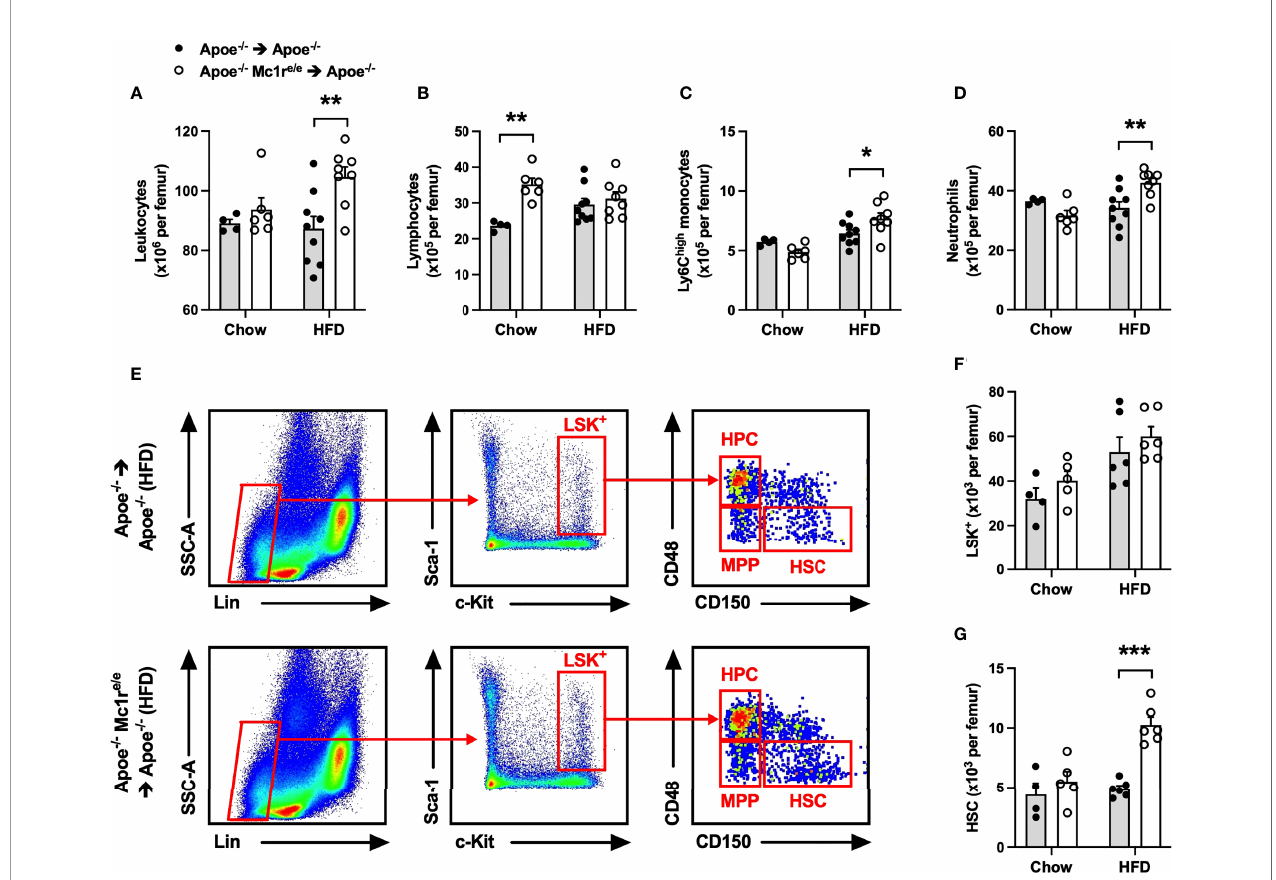
FIGURE 2 | Hematopoietic MC1-R de fi ciency increased leukocyte and hematopoietic stem cell counts in the bone marrow of Apoe -/- recipient mice. (A – D) Quanti fi cation of total leukocytes (CD45 + ), lymphocytes (CD45 + , CD11b - ), neutrophils (CD45 + , CD11b + , Ly6G + ) and Ly6C high monocytes (CD45 + , CD11b + , CD115 + and Ly6C high ) in the bone marrow of Apoe -/- and Apoe -/- Mc1r e/e chimeric mice. (E) Representative dot plots for the gating of LSK + (Lin - , Sca-1 + , c-Kit + ), MPP (CD48 + , CD150 - ), HPC (CD48 - , CD150 - ), HSC (CD150 + , CD48 - ) cells in the bone marrow of Apoe-/- recipient mice. (F, G) Quanti fi cation of LSK + and HCS (Lin1 - , Sca-1 + , Kit + ; and CD150 + , CD48 - ) cells in the bone marrow. Data are mean ± SEM, *P ≤ 0.05, **P < 0.01, ***P < 0.001 versus Apoe -/- mice. Each dot represents individual mouse. Lin - indicates lineage-negative; Sca-1, stem-cell antigen-1; c-Kit, proto-oncogene receptor tyrosin kinase; MPP, multi-potent progenitor; HSC, hematopoietic stem cell; HPC, hematopoietic progenitor